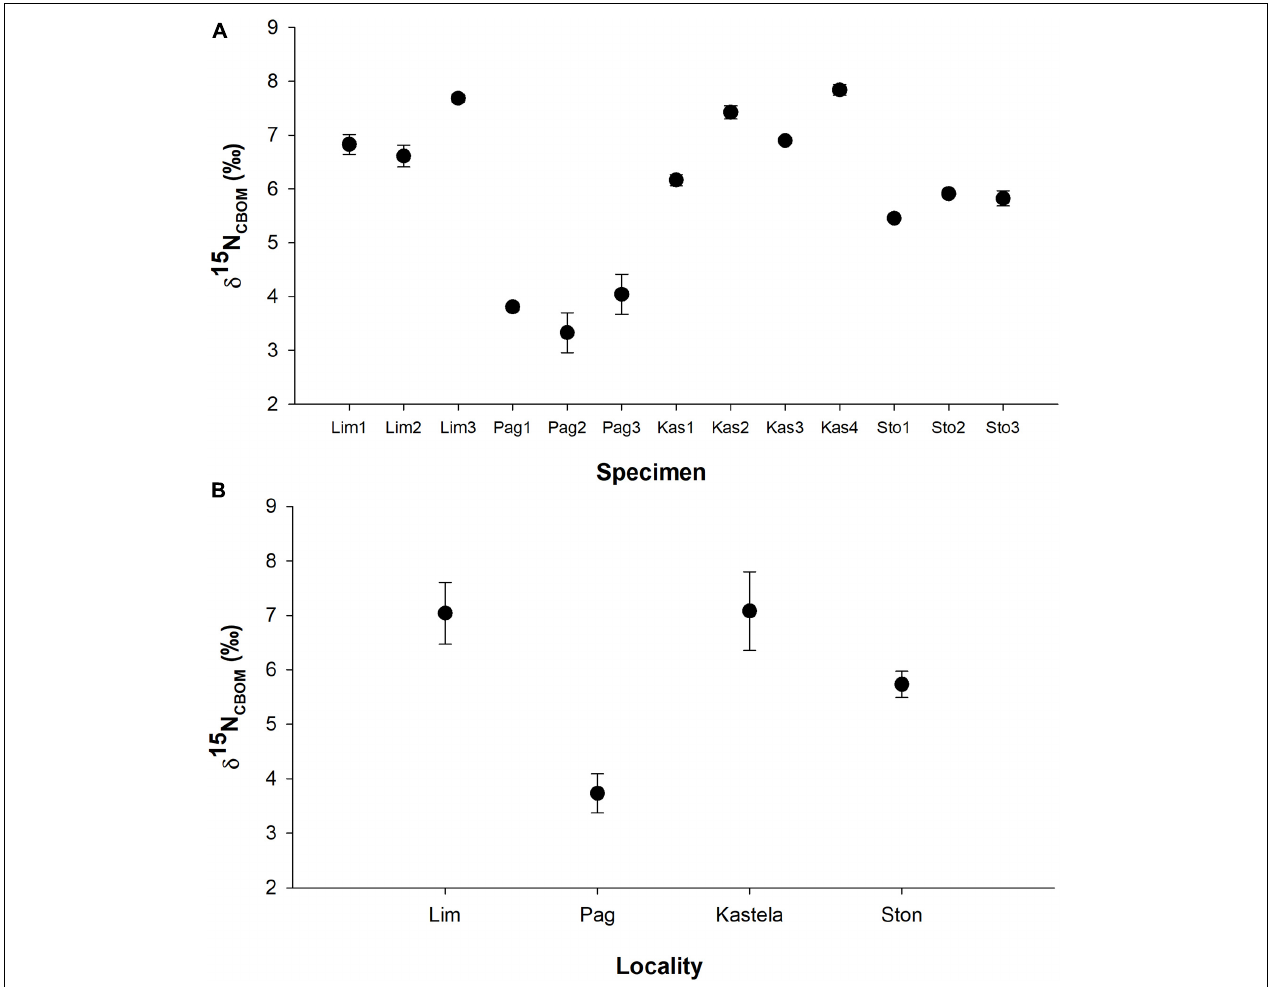
FIGURE 3 | δ 15 N CBOM values of the inner shell surface of Pinna nobilis . (A) Data of the three milling lines per specimen, (B) differences between locality averages. Mean values ± 1 standard deviation (often smaller than the